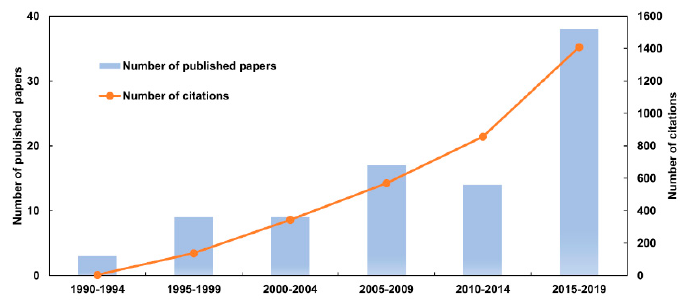
Figure 3. Number of published papers and citations.